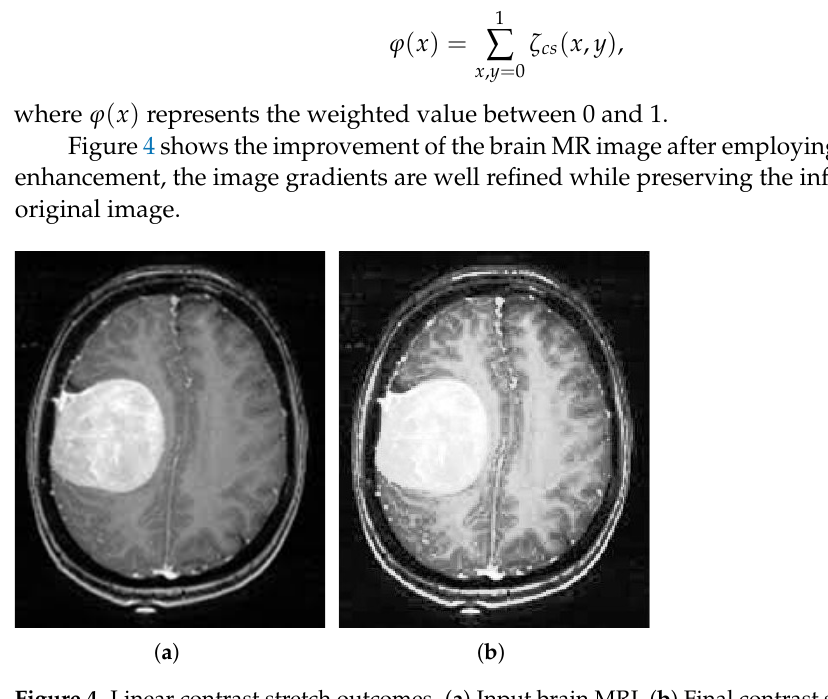
Figure 4. Linear contrast stretch outcomes. ( a ) Input brain MRI, ( b ) Final contrast stretch